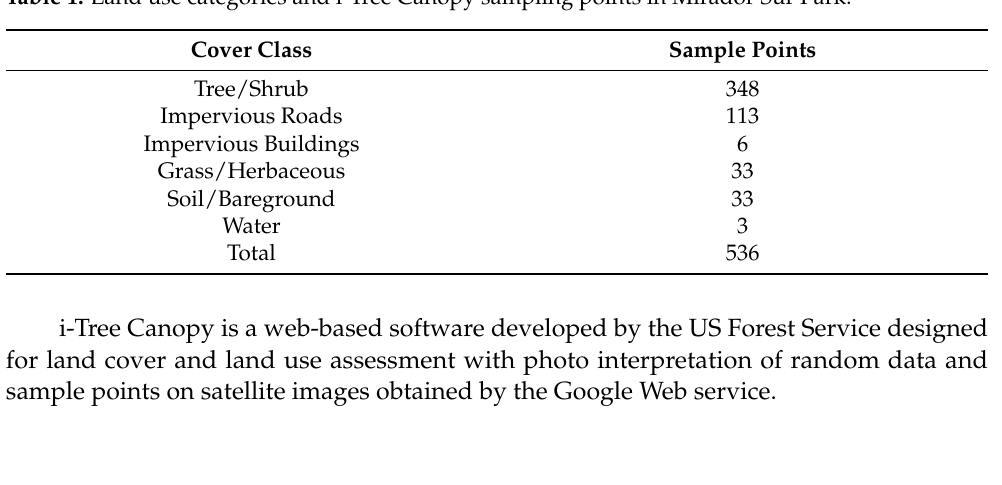
Table 1. Land use categories and i-Tree Canopy sampling points in Mirador Sur